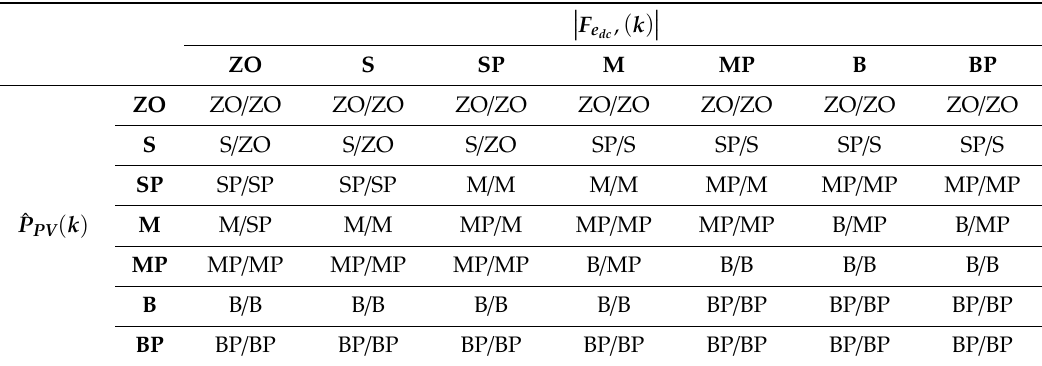
Table 2. Fuzzy Rules For K P , f / K I , f in Rule i